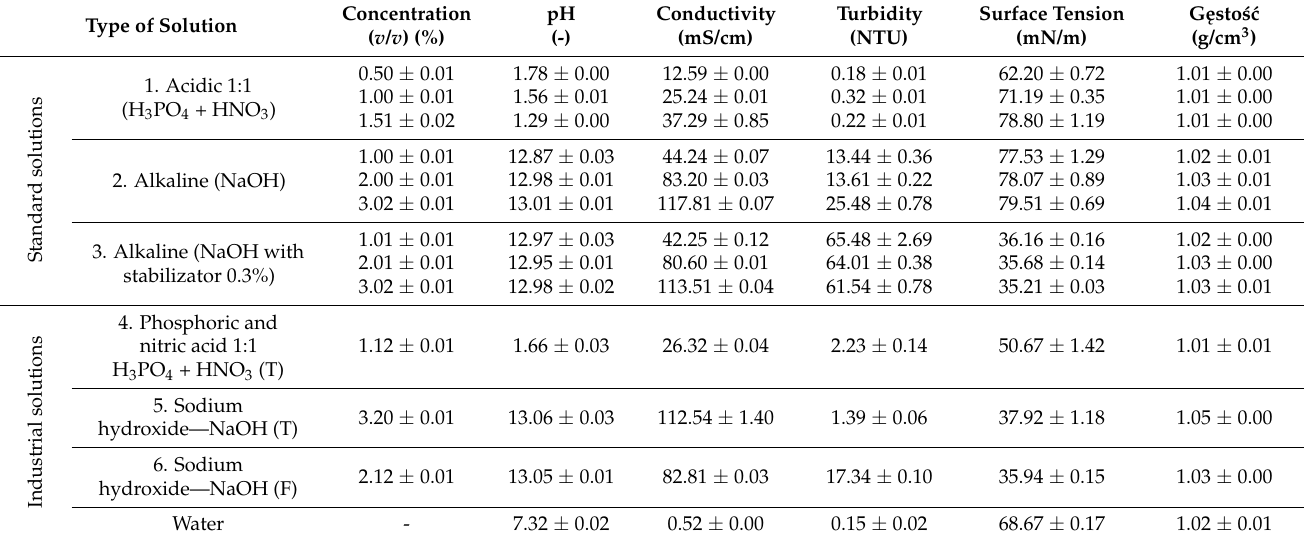
Table 2. Properties of CIP solutions after 12 weeks of